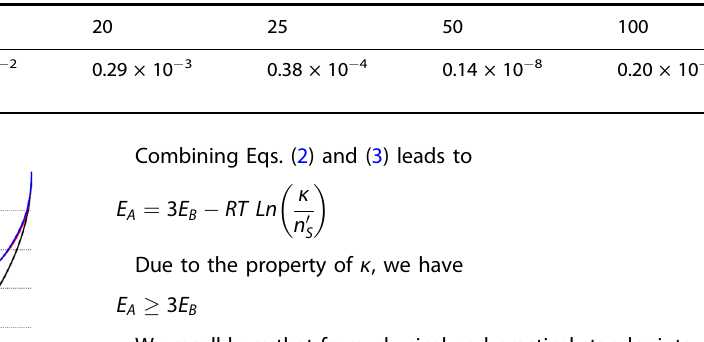
Table 2. Activation energies and corresponding bond-breaking probabilities used in the simulations.